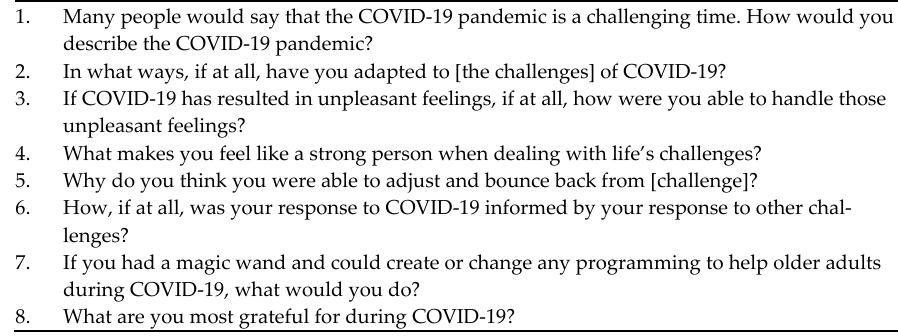
Figure 1. These eight questions were used as the interview guide to structure interviews.